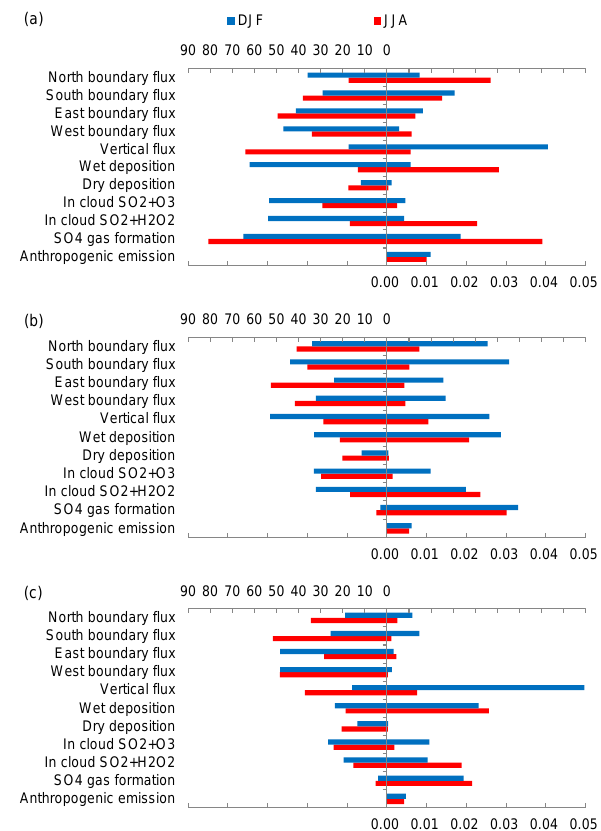
Figure 9. Sulfate budget (mass flux from each process in TgSseason − 1 , right) and APDM of each flux (%, left) in (a) NC, (b) SC, and (c) SCB obtained from simulation ANNmet. Blue lines are for DJF and red lines are for JJA. Transport fluxes were calcu- lated at the boundaries while other sources and sinks were calcu- lated as the sums over the grid cells of the region under